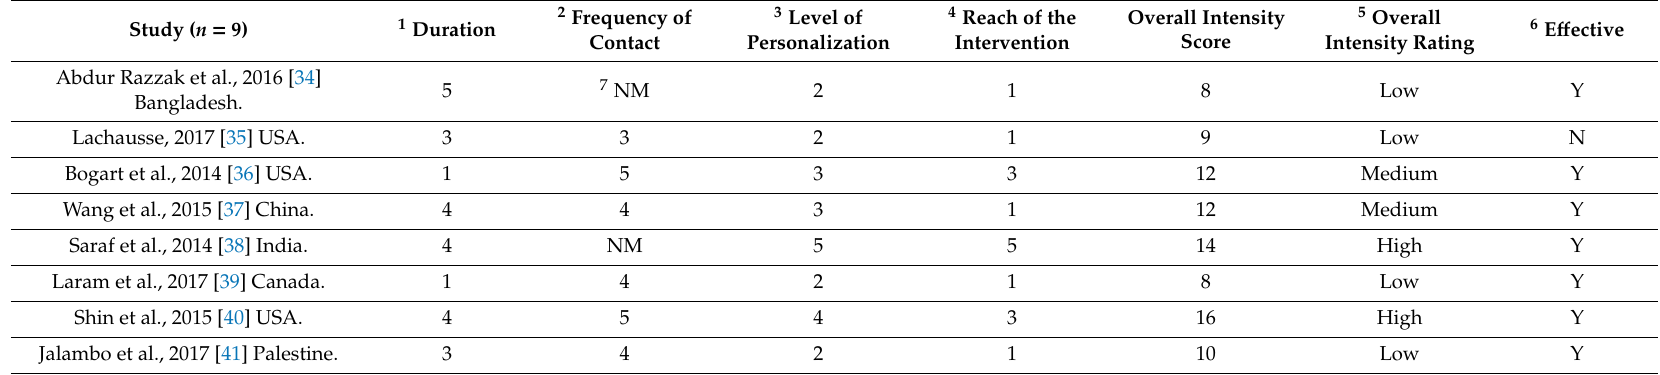
Table 2. Summary of overall intervention